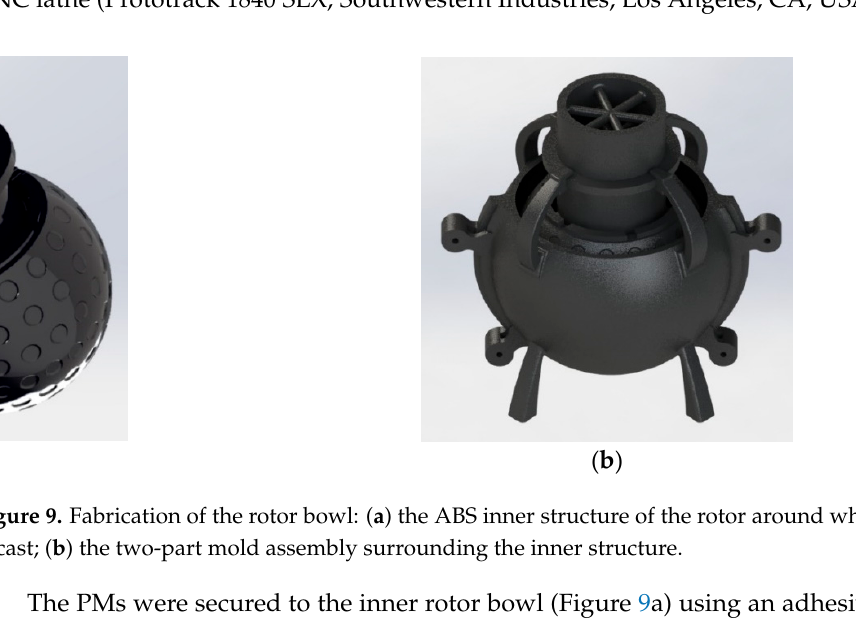
Table 2. Normalized x , y , z coordinates and polarity of rotor PMs.